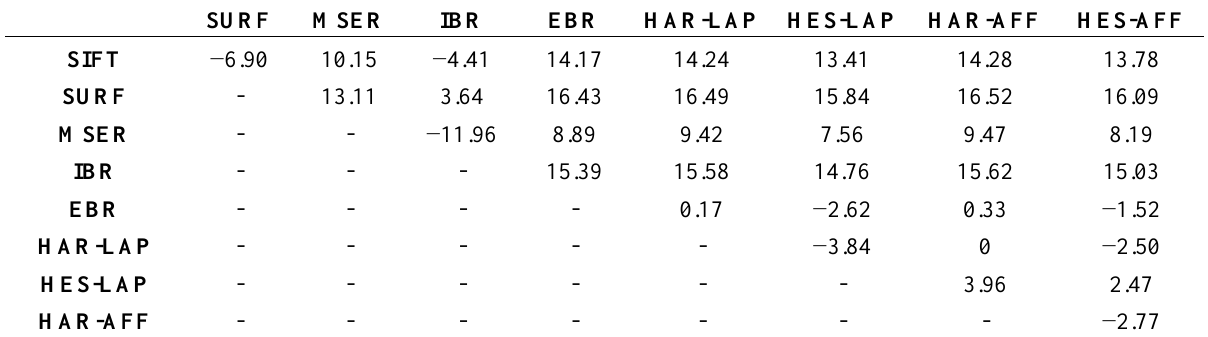
Table 2. A summary of McNemar’s test results (computed Z -score) for state-of-the-art detectors; negative values indicate that the detector mentioned on the top performs better than the detector shown on the left hand